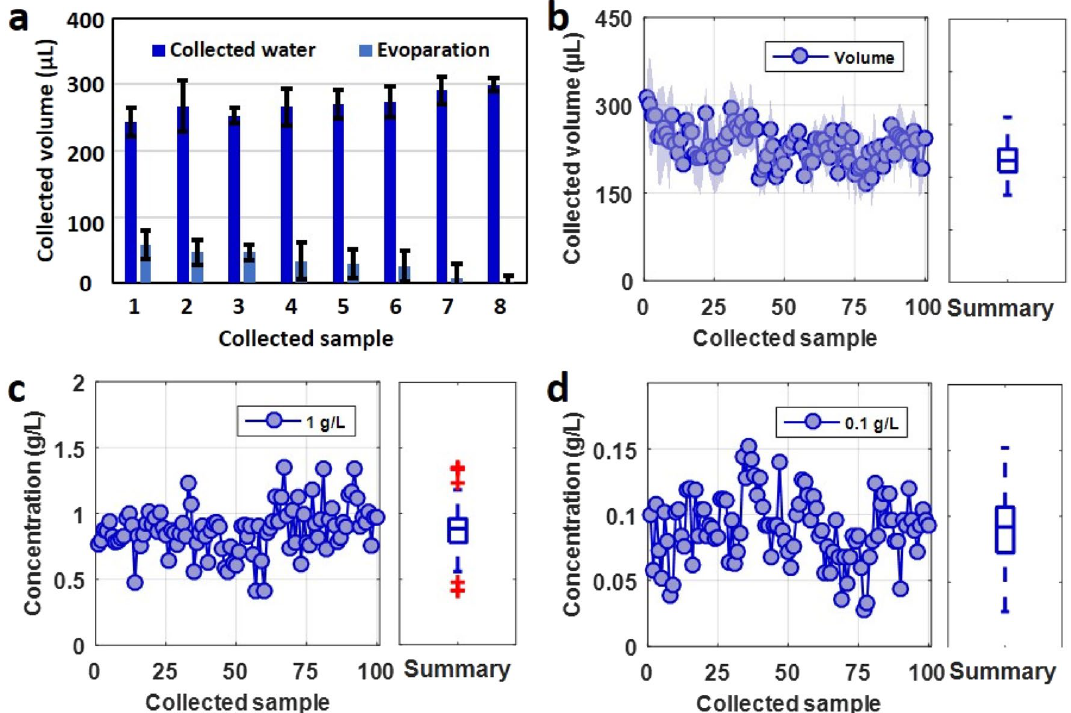
Figure 3. Cyclic sample collection and protein quantification for clean and pre-treated collectors. ( a ) Collected water volume and its evaporation rate in the vials of rotating turret for each cycle. The vial turret automatically collects a sample at 3-h intervals. Error bars show the standard deviation (n = 5). ( b ) Volume of samples collected by the custom-designed sample collector for each cycle. Total number of cycles, interval period per cycle, and total experiment time are 100 cycles, 3 h, and 300 h, respectively. The collected volume is summarized by a boxplot, at right. ( c ) Quantification of protein concentration in 100 collected samples via a plate reader for applied concentration of 1 g/L. Results show an average of approximately 0.87 g/L. The protein concentration is summarized by a box chart, at right. ( d ) Quantification of protein concentration in 100 collected samples via a plate reader for applied concentration of 0.1 g/L. Results show an average of approximately 0.09 g/L. The protein concentration is summarized by a box chart, at